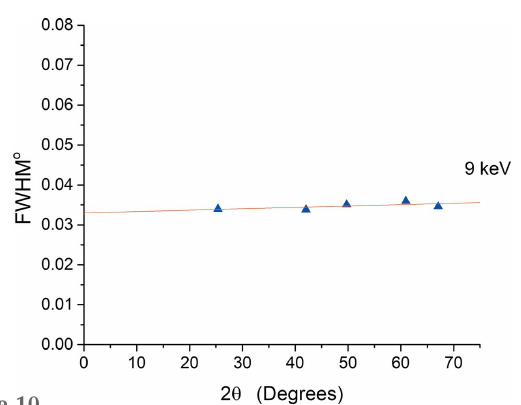
Figure 10 Instrumental angular resolution function measured by Si (NIST 640f) at 8 keV.